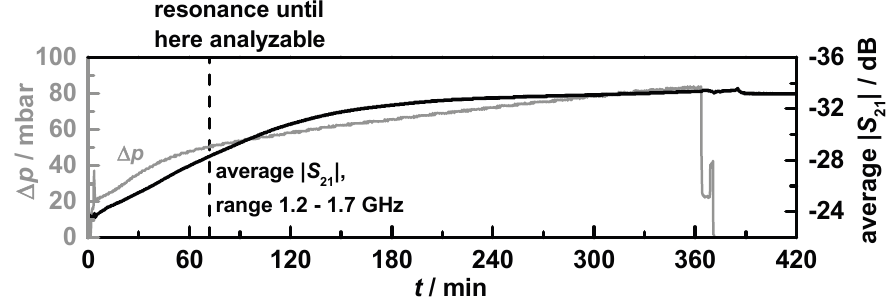
Figure 11. Entire 6 h-lasting soot loading run (filter C1 ). Differential pressure (grey) and averaged transmission parameter in the frequency range from 1.2 to 1.7 GHz (black) agree well. After ca. 70 min (black dashed line), the losses were too high and the resonance peak could not be evaluated